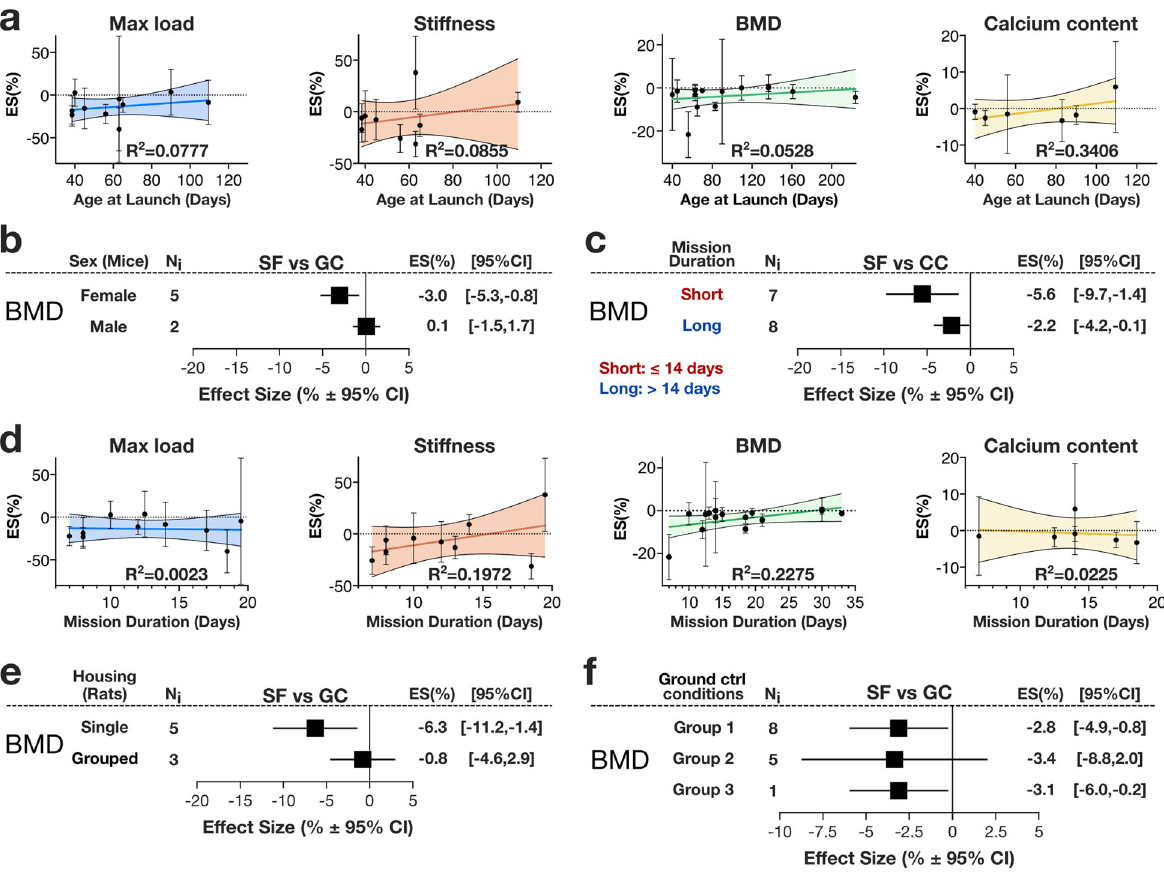
Fig. 7 Covariate analysis of space fl ight-induced changes in bone strength and composition. a Meta-regression analysis of max load, stiffness, BMD, and calcium content as a function of age at launch of SF animals. Linear regression line ( dark color ), its 95% CI ( light color area ) and R 2 are shown. Subgroup analysis of BMD by animal sex ( b ) and by short (14 days or less) and long (greater than 14 days) mission duration ( c ). Square/line: effect size (%) and 95% CI. N i: number of mission level outcomes. d Meta-regression analysis of max load, stiffness, BMD, and calcium content as a function of mission duration. Linear regression line ( dark color ), its 95% CI ( light color area ) and R 2 are shown. Subgroup analysis of BMD by single vs. grouped rat housing ( e ) and by how closely GC mimics SF conditions ( f ). For f: Group 1: GC housed in same habitat as the SF; Group 2: GC housed in same habitat as SF, the force of liftoff and/or re-entry were mimicked; Group 3: GC was mimicked by in- fl ight centrifuge. Square/line: effect size (%) and 95% CI. N i: number of mission level